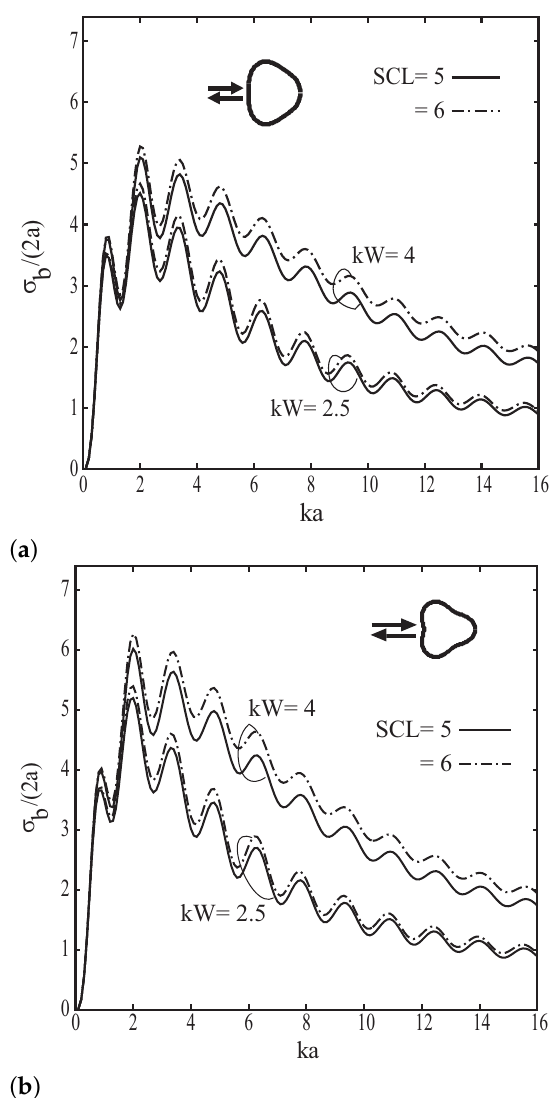
Figure 6. Target size versus LRCS in a disordered medium for a concave illumination region ( θ = 0) where ( a ) δ = 0.08, ( b ) δ =